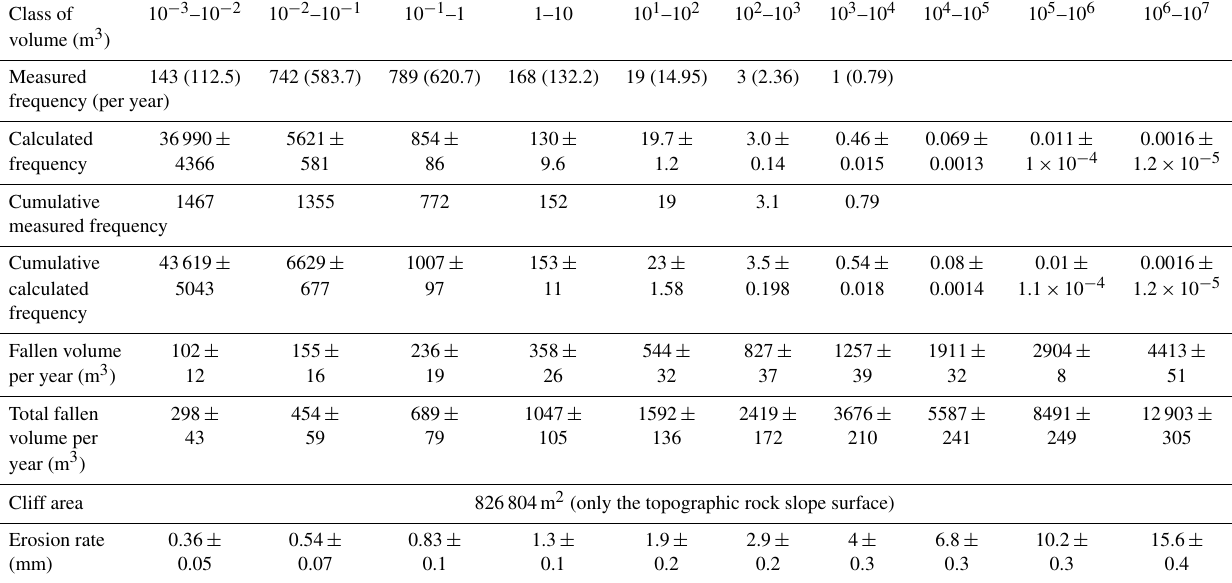
Table 6. Rock slope debris production rate estimated from the inventory analysis using power law distribution of volume for potential rockfall (Fig.